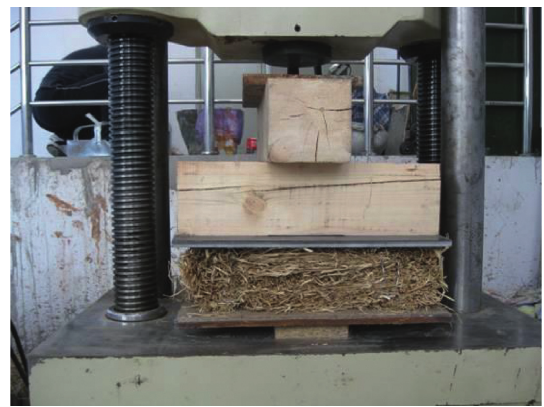
Figure 7: The large deformation of straw bale.